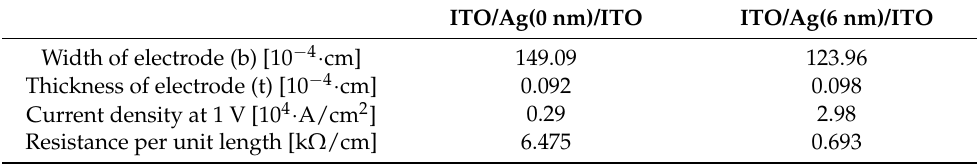
Table 2. Electrical characteristics of laser-ablated ITO SL and ITO/Ag/ITO ML electrodes. ITO/Ag(0